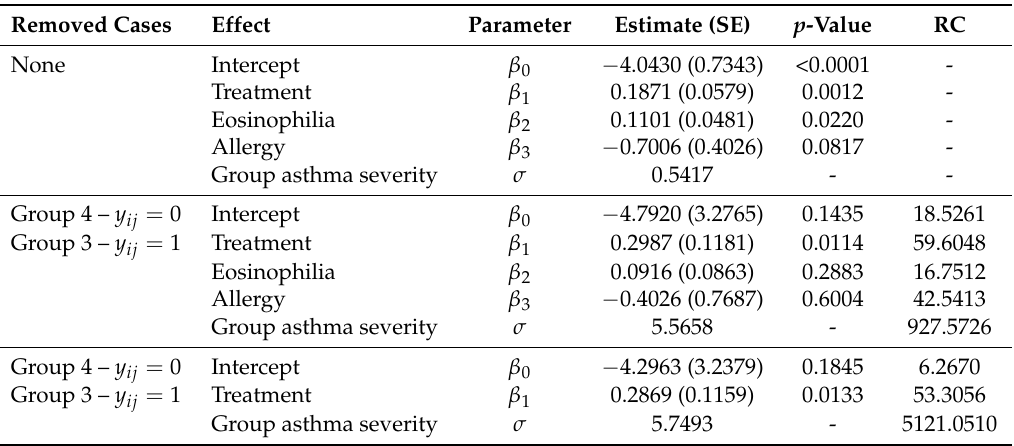
Table 12. Estimates (SE), p -values and RC under data-influence analytics for the asthma data.